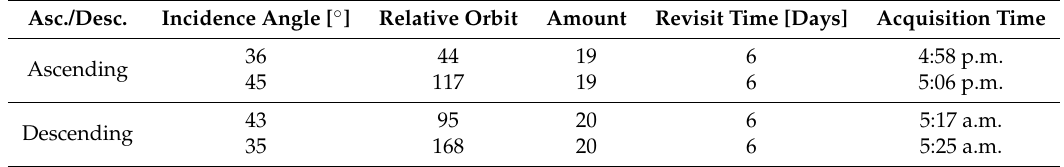
Table 3. Available Sentinel-1A/B satellite data for MNI field campaign period in 2017 (03/23–07/17/2017).